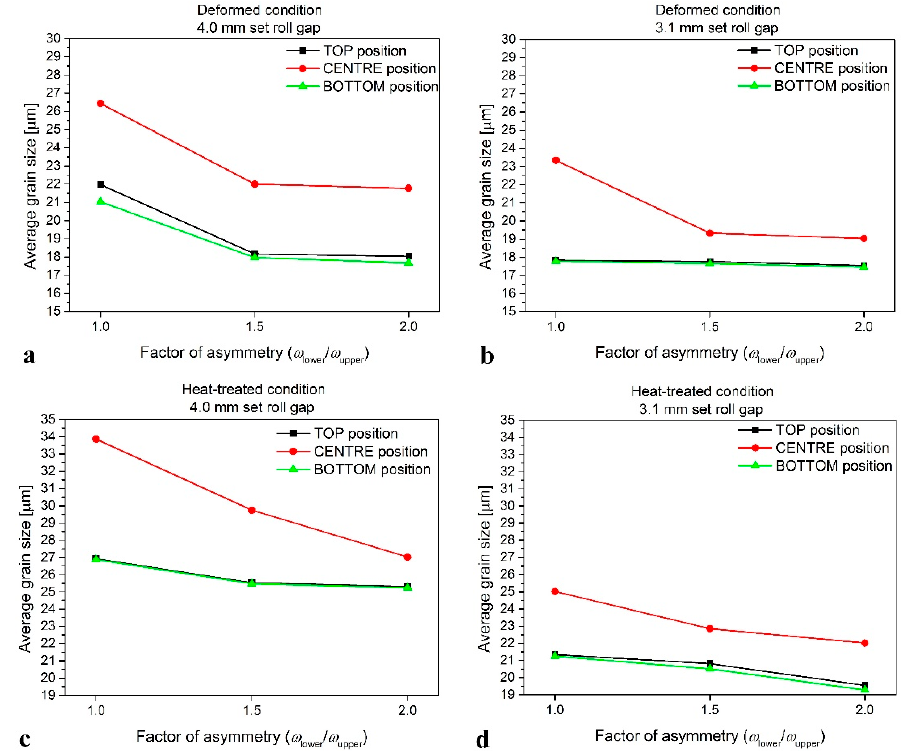
Figure 5. Average grain size for deformed condition with 4.0 mm set roll gap ( a ), deformed condition with 3.1 mm set roll gap ( b ), heat treated with 4.0 mm set roll gap ( c ) and heat treated with 3.1 mm set roll gap ( d ).